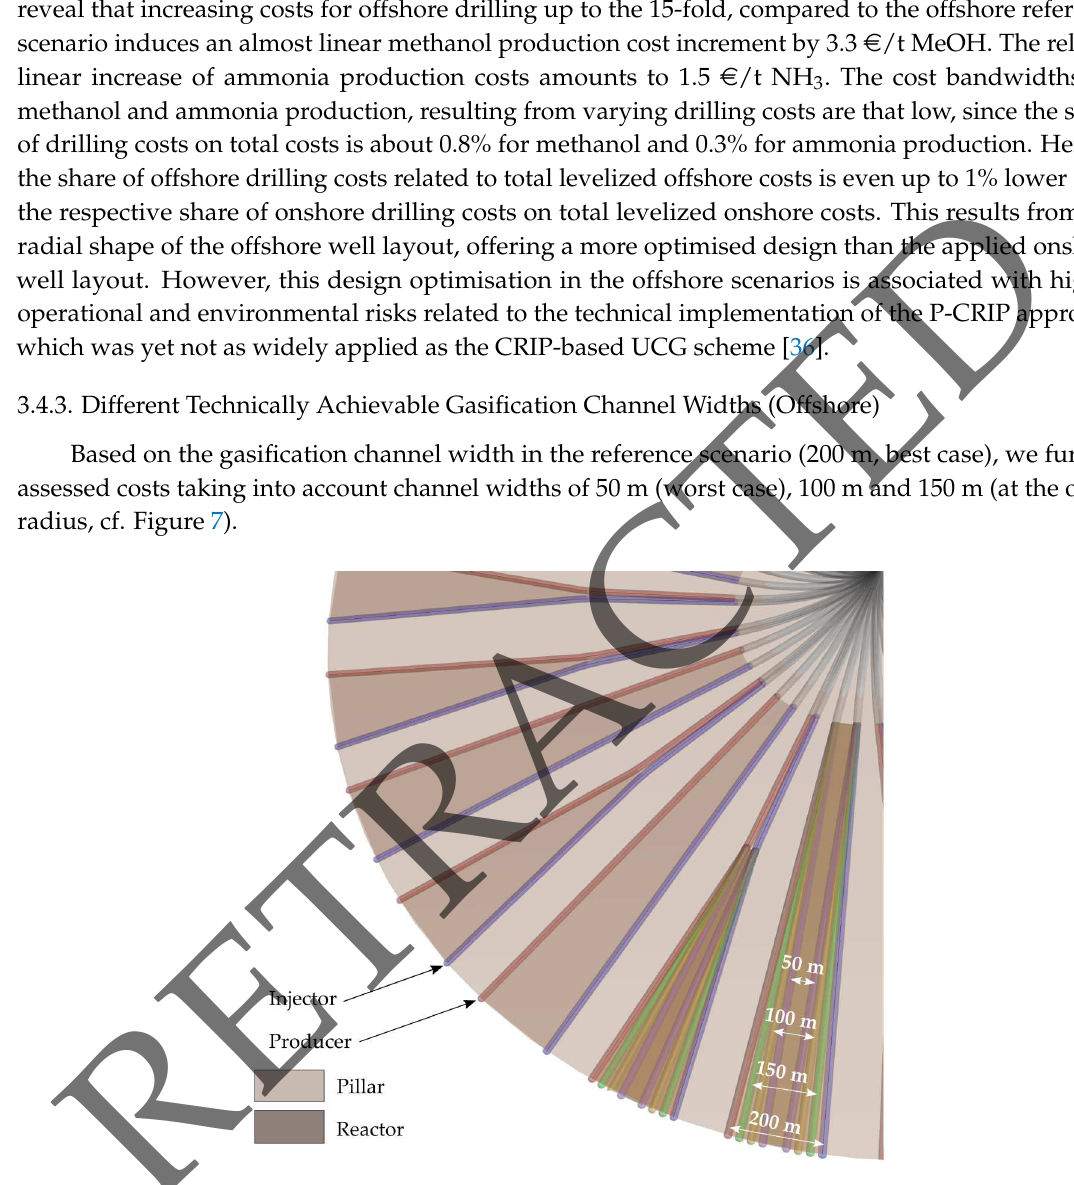
Figure 7. Gasification channel design for different channel widths (50 m to 200